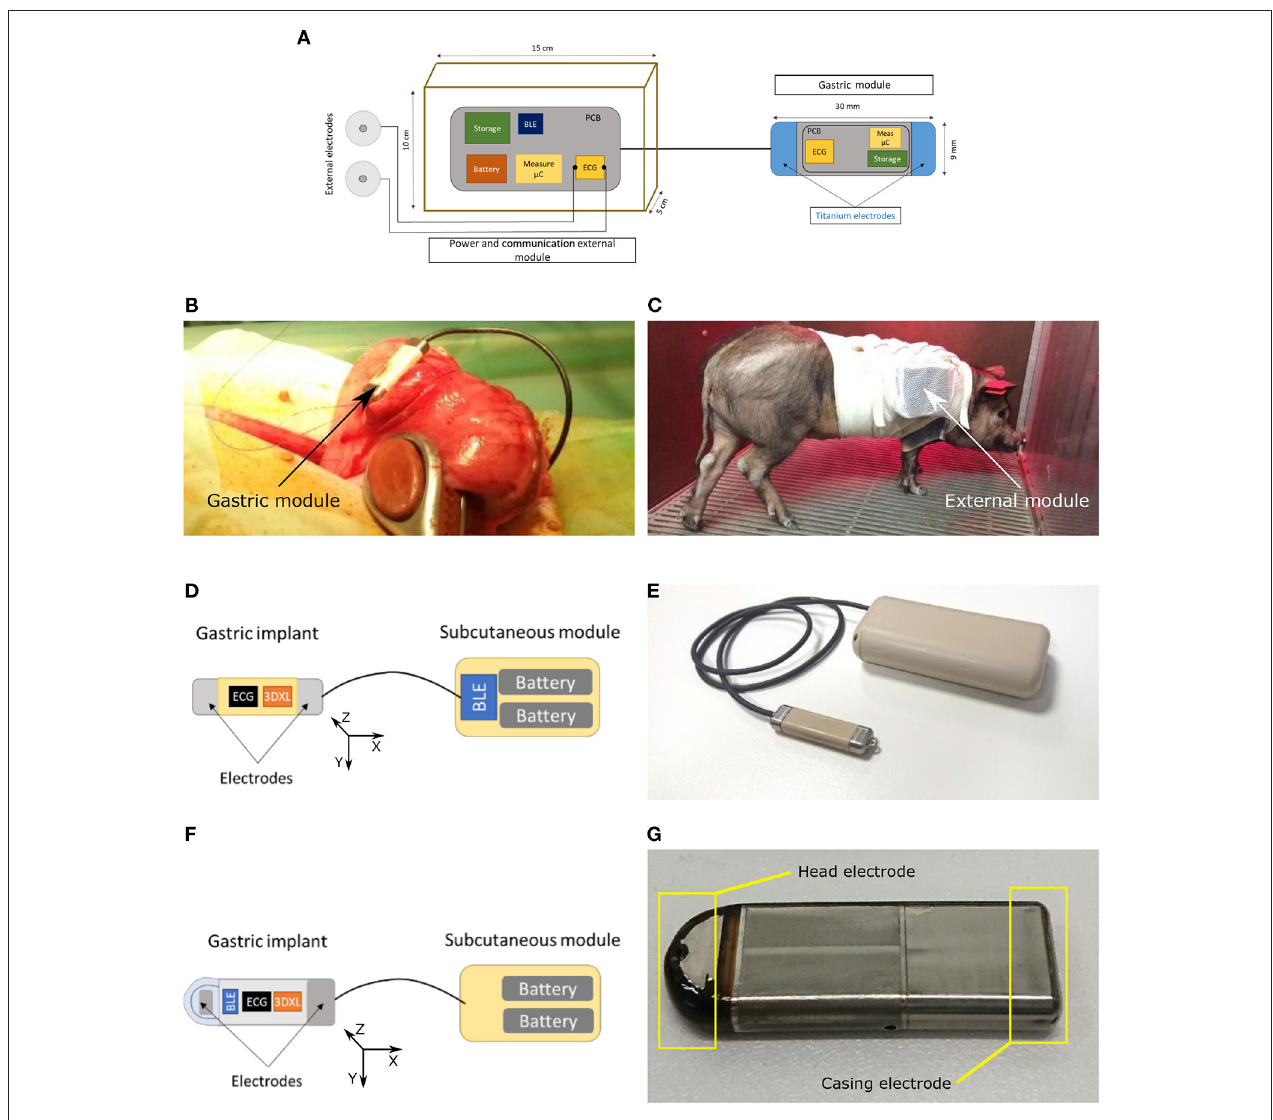
FIGURE 1 | Implant prototypes used for acquiring the ECG and ACC data. (A) Schematic representation of the implant prototype V0. (B) Physical design of the gastric implant prototype V0. (C) Physical design of the external module of prototype V0. (D) Schematic representation of the implant prototype V1. (E) Physical design of the implant prototype V1. (F) Schematic representation of the implant prototype V2. (G) Physical design of the gastric module of the implant prototype V2.